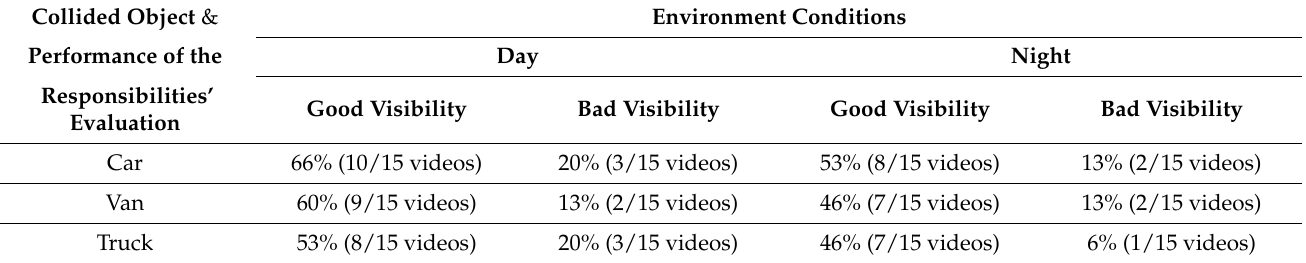
Table 4. Results of the module in evaluating responsibilities without user’s manual